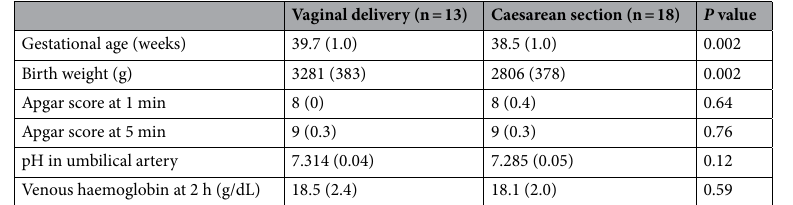
Vaginal delivery (n = 13) Caesarean section (n = 18) P